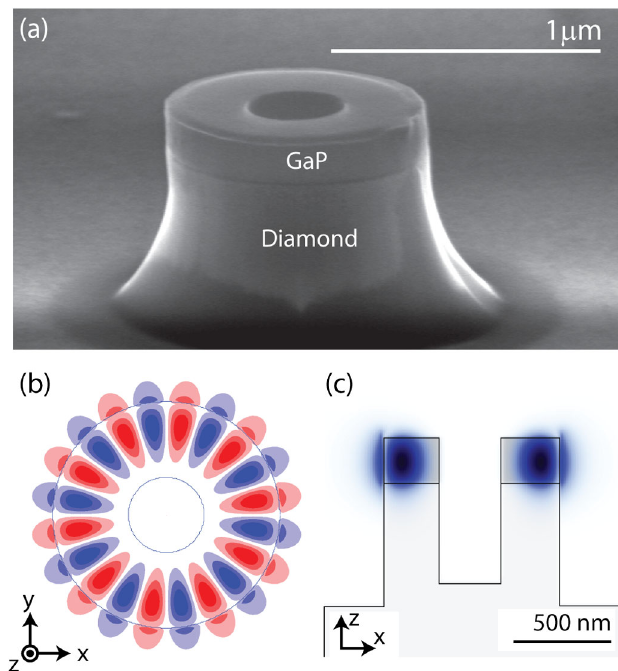
FIG. 1. (a) Scanning electron microscope image of a hybrid GaP-diamond whispering gallery mode nanocavity. (b) Top-view and (c) cross-section of the dominant electric field component E r of the lowest order TE-like standing-wave mode supported by the device in (a), with resonance wavelength (cid:1) o (cid:1) 637 nm . The fields are calculated using finite difference time domain simula- tions. The field in (b) is plotted in the x - y center-plane of the GaP